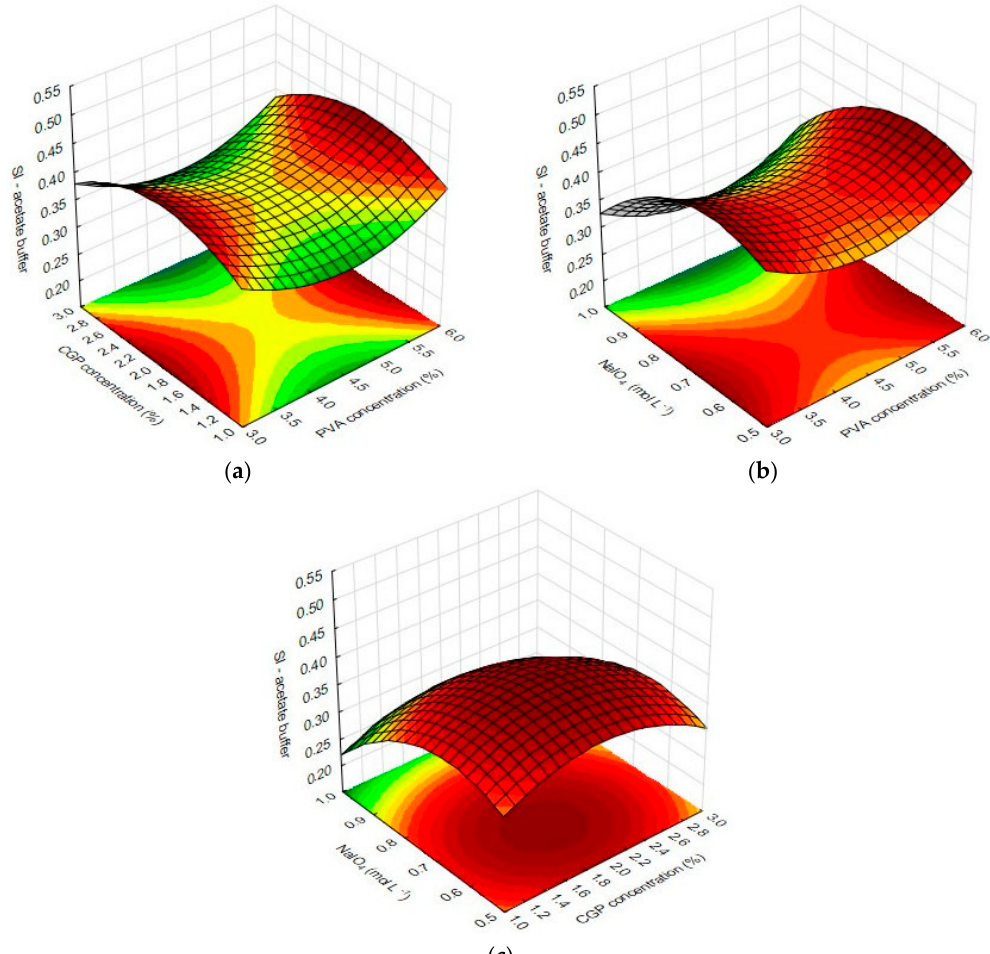
Figure 3. Response surface plots for swelling indexes of CGP/PVA films in acetate buffer as function of the significant factors: ( a ) effect of CGP and PVA concentrations; ( b ) effect of NaIO 4 and PVA concentrations; and ( c ) effect of NaIO 4 and CGP concentrations.